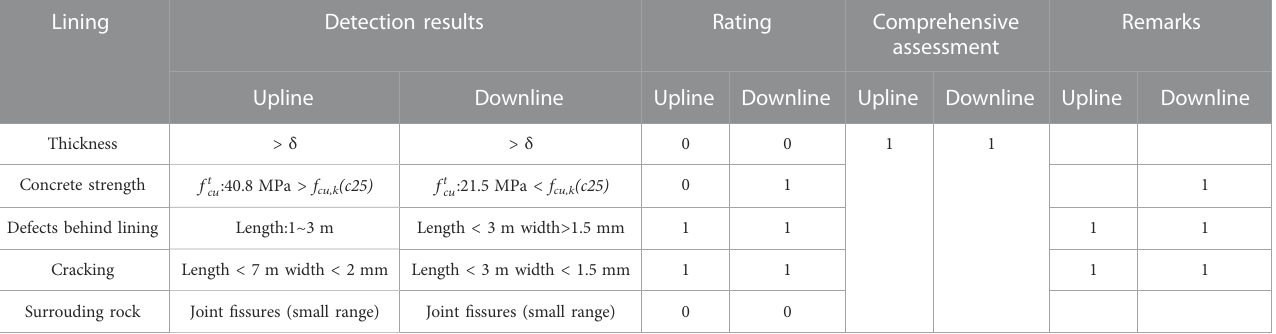
TABLE 3 Soundness rating form of operational tunnels of Chongqing-Huaihua railway.